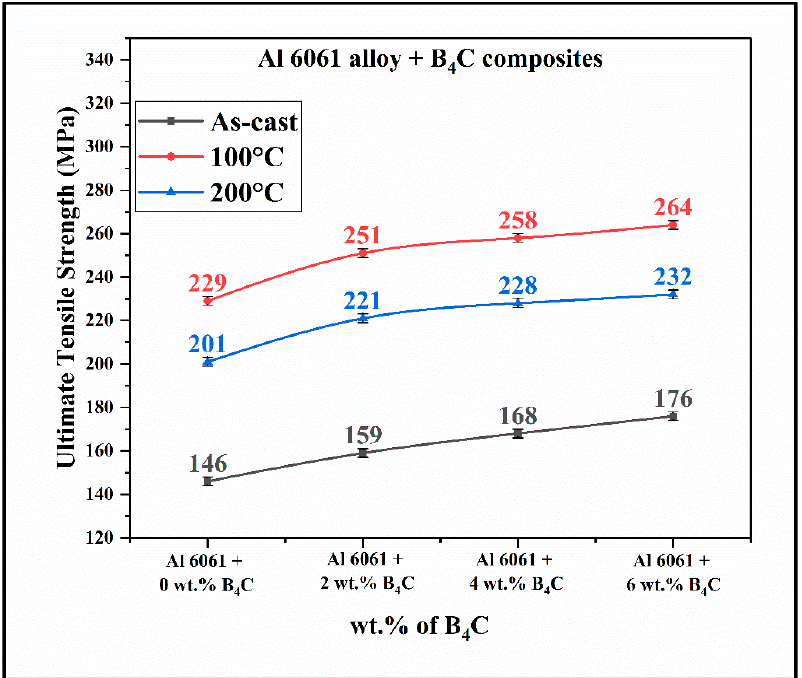
Figure 5. Variation of tensile strength with increase in content of SiC particles on Al 6061 alloy under different peak aging conditions.